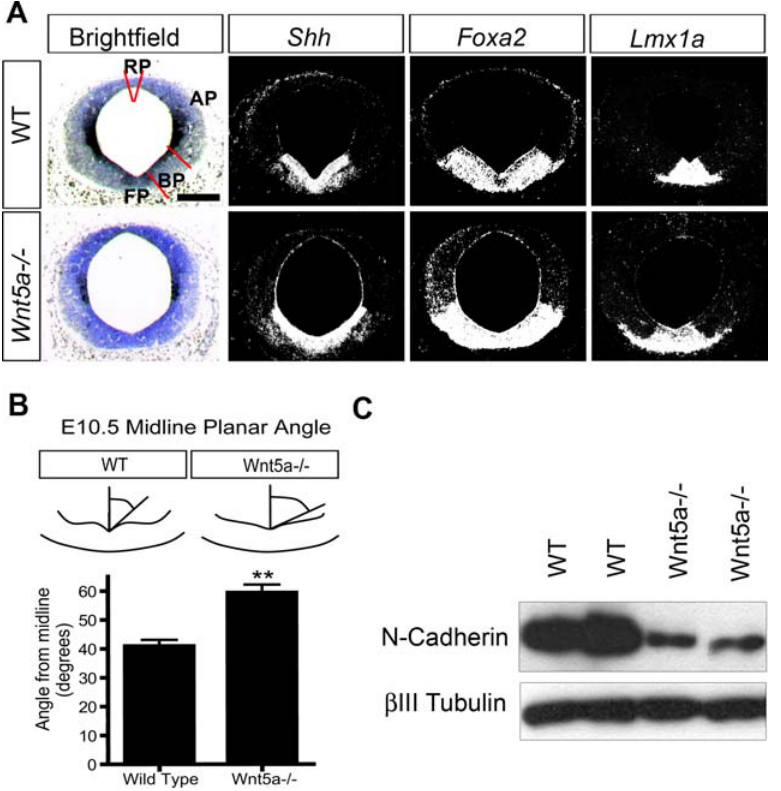
Figure 6. Lateral expansion of Sonichedgehog expression and flattening of midbrain ventricle, associated with loss of N-cadherin in Wnt5a 2 / 2 embryos. (A) Shh , Foxa2 and Lmx1a are laterally expanded by E11.5 in Wnt5a 2 / 2 mice. The invagination at the medial hinge-point is markedly reduced/flattened in the mutants. Red bars delimit the alar plate (AP), basal plate (BP), floor plate (FP) and roof plate (RP). Scale bar 250 m m. (B) The flattened VM invagination was quantified by measuring the angle formed between the midline and the ventricular wall at several levels throughout the VM of E10.5 mice, when this morphological change first became obvious. A significant difference was found in the Wnt5a 2 / 2 mice forming a U-shaped ventricle, with an angle of 59.4 u 6 2.8 u from the midline as compared to 49.1 u 6 4.3 u in WT mice. (C) Western blot of E9.5 whole brain of WT and Wnt5a 2 / 2 mice revealed a marked reduction of N-cadherin in Wnt5a 2 / 2 mice.